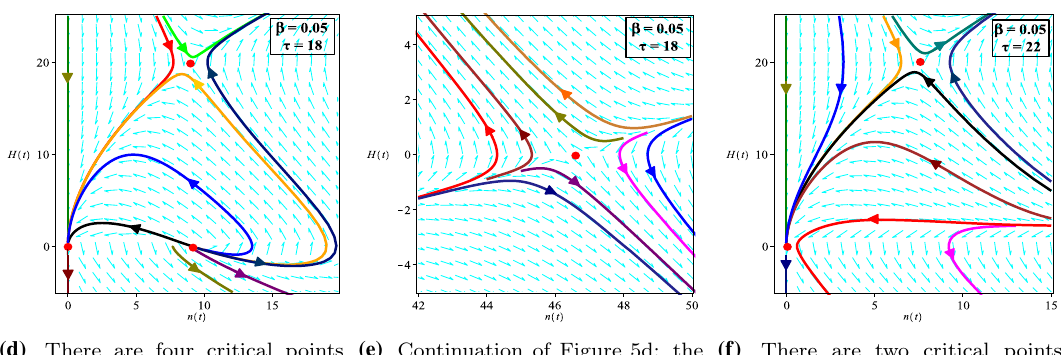
(e) Continuation of Figure 5d: the critical point at ( n ∗ = 46 . 53 , H ∗ = 0) is a